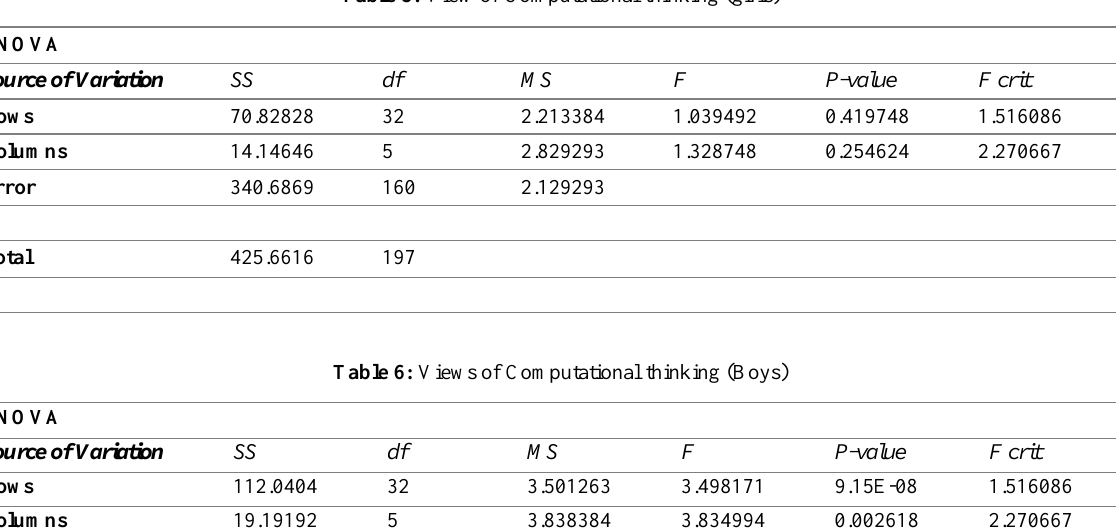
Table 5: View of Computational thinking (girls)